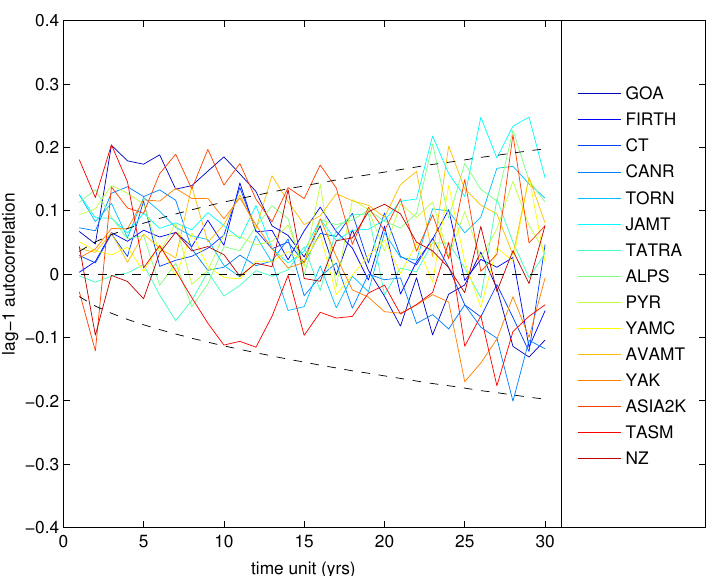
Figure 4. Estimated lag-1 autocorrelation for time units from 1 to 30 years in the 3000-year-long unforced control simulation. Two-sided 5% significance levels for a white noise process are shown with dashed lines. Data for each region, identified by the colour legend to the right, are for the season as specified in Table